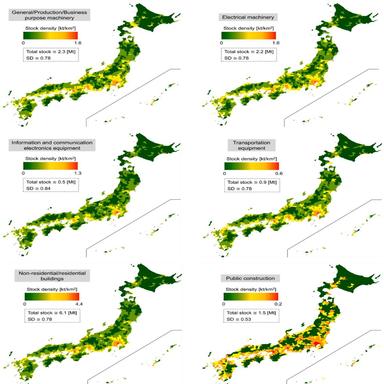
Spatial distribution of in-use copper stocks for 10 final product groups in Japan in 2011. Municipalities are colored based on geometric interval classification.